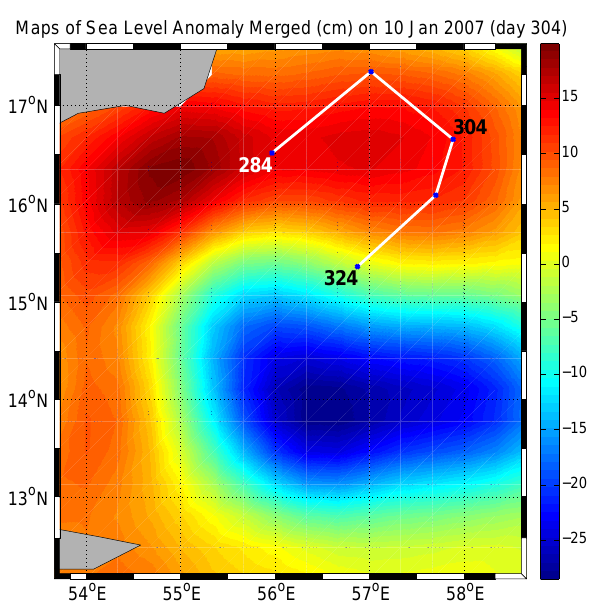
Fig. 15. Altimetric maps of 6 September 2006 (day 189 of the mis- sion) and of 7 January 2007 (day 304 of the mission), with the tra- Figure 15: Altimetric maps of September 6th 2006 (day 189 of the mission) and of jectory of float 2900104 superimposed. Dots indicate the position days.28 January 7th 2007 (day 304 of the mission), with the trajectory of float 2900104 super- of the float every 10 days. imposed. Dots indicate the position of the float every 10